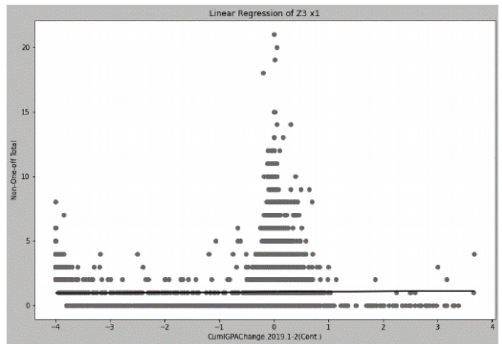
Figure 5. Linear Regression of Z3 x1 in Finding 1